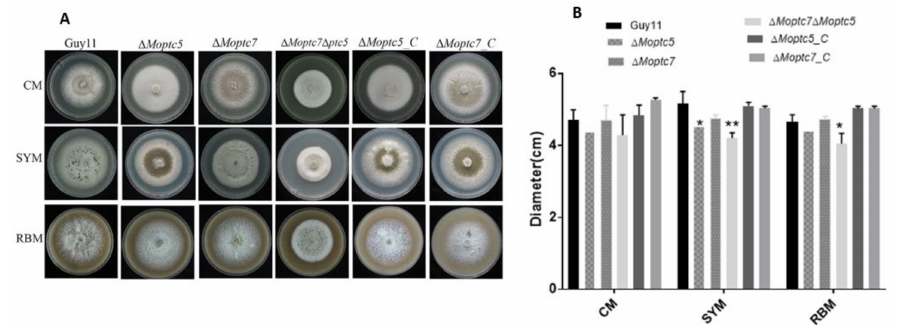
Figure 3. Synergistic roles of MoPtc5 and MoPtc7 in M. oryzae vegetative growth of. ( A ) The growths of the various strains on different media plates. CM, SYM and RBM were used for the growth of the fungal mycelia and incubated in the dark for 10 days at 28 ◦ C. ( B ) Bar graphs showing the colony diameters of the various strains on the indicated media. Asterisks show significant differences at different p -values (* p < 0.1; ** p < 0.01) while error bars represent standard deviations from three independent replicates. The data were analyzed by one-way ANOVA using Tukey’s multiple-comparison